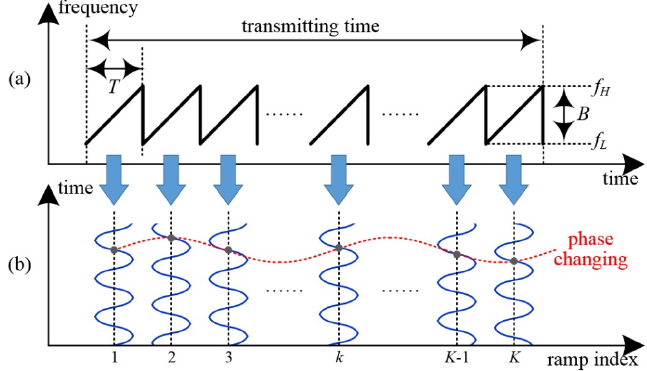
Figure 1. Basic concept of fast-ramp based 2D range-Doppler FMCW radar: ( a ) transmitted signal in the frequency-time domain; and ( b ) beat signal for a single moving target in ramp index domain. Here, T is modulation period, B is bandwidth, f H is maximum instantaneous carrier frequency, f L is the lowest carrier frequency, and K is the number of